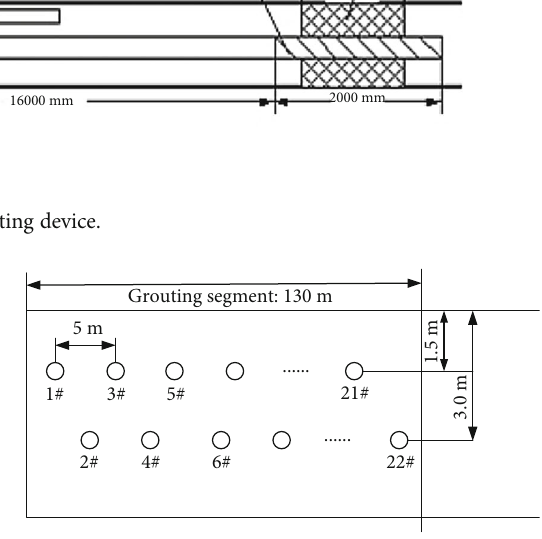
Figure 6: Layout of